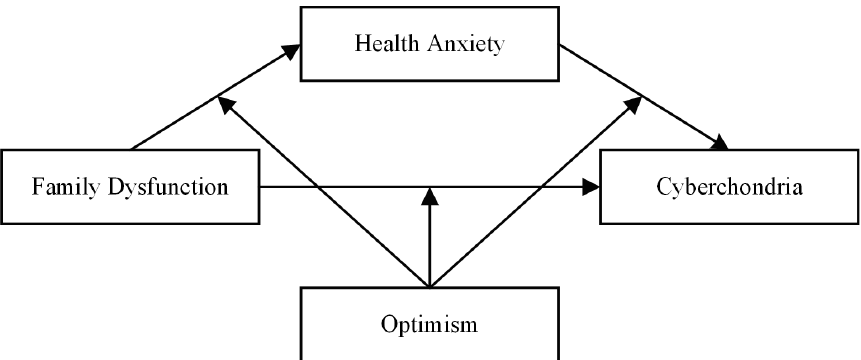
Figure 1. Conceptual model.